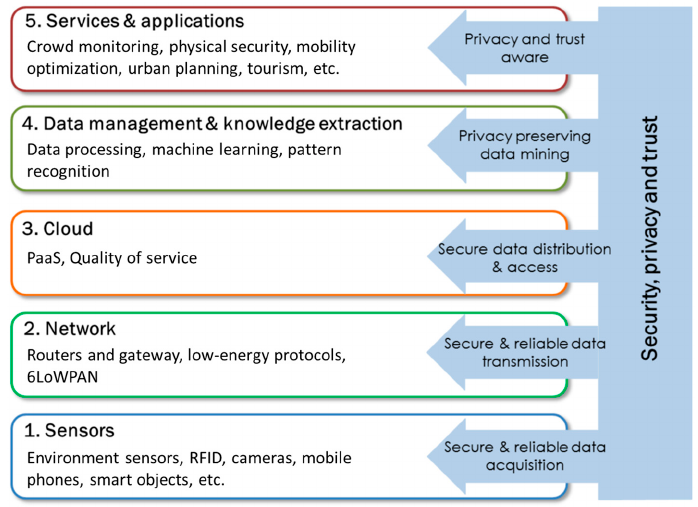
Figure 2. iNUIT architecture divided in five layers from the sensors (bottom) to the services (up).